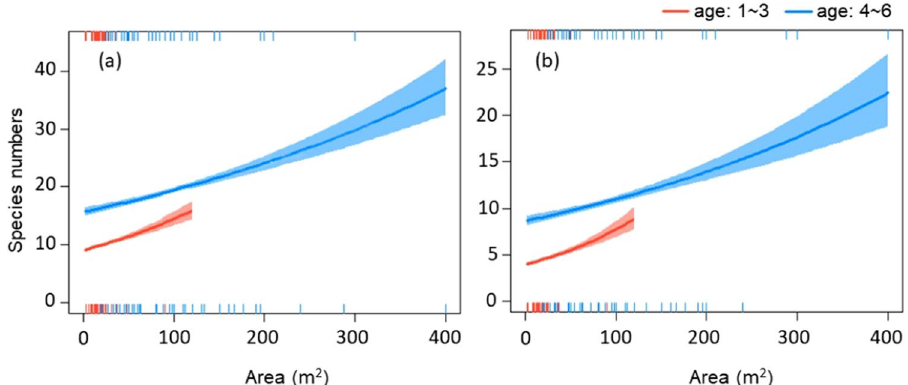
Figure 3. Effects of the interaction between area and age on species numbers of all plants ( a ) and insect- pollinated plants ( b ). The red line shows the effect trend of area on plant species numbers in young graveyards (< 4 generations), while the blue line represents the trends for older graveyards. The colored areas reflect the 95% confidence intervals for the two